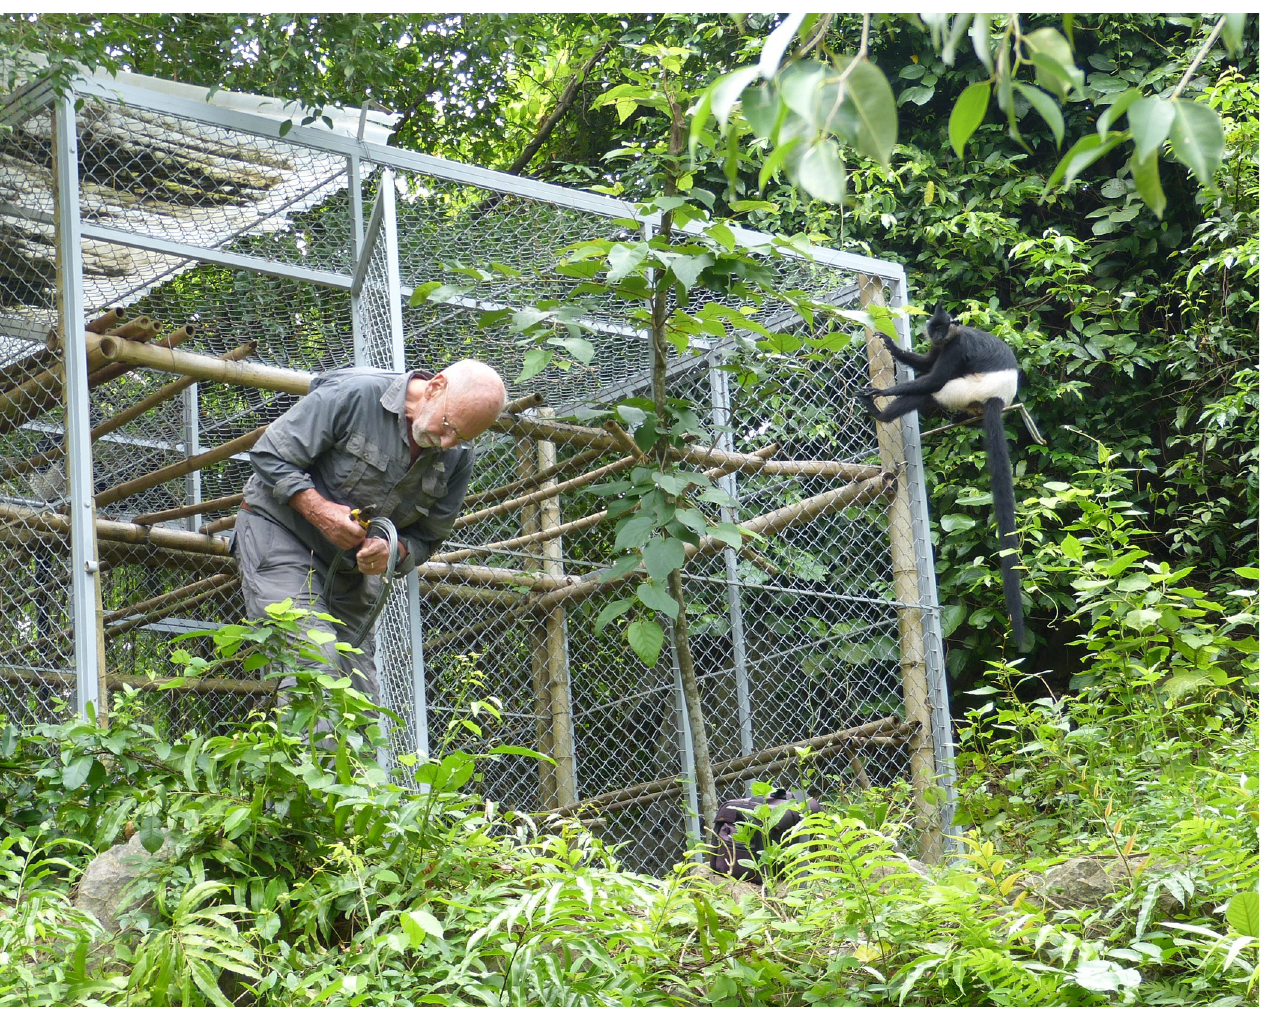
Fig 10. Monitoring visit to the Delacour’s langur trial reintroduction site on Ngoc Island, Tr à ng An (2022). The release cage was used for initial climatization purposes and continues to serve as contact location between the free-ranging primates and monitoring staff (Photo: Ryan